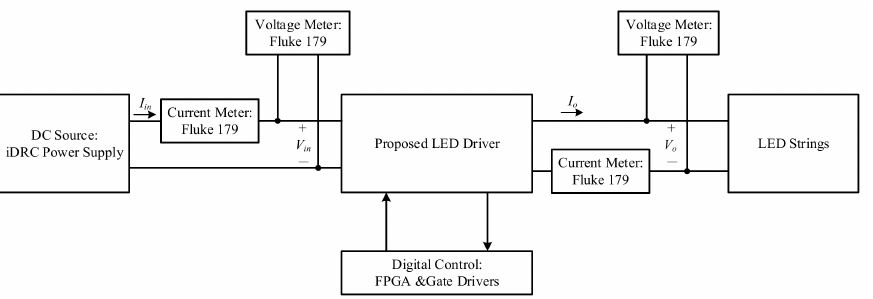
Figure 34. Block diagram of efficiency measurement.